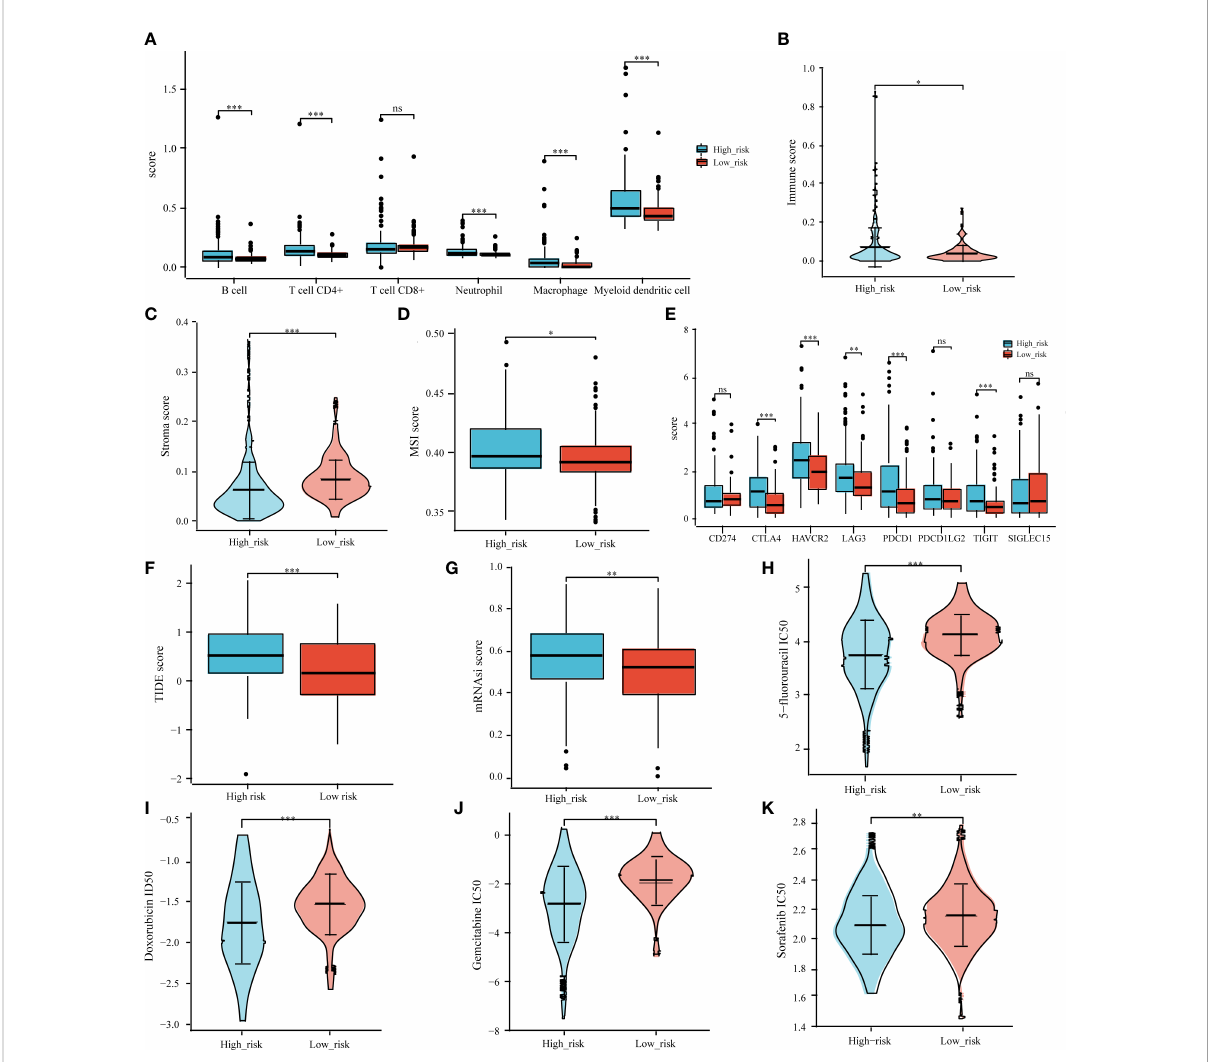
FIGURE 9 Correlation analysis of prognostic signature and tumor immune cell in fi ltration, immune checkpoint inhibitors, ICB response, MSI, tumor stemness, and common chemotherapeutic agents. Associations between the IICDL signature and tumor immune cell in fi ltration (A) , immune score (B) , stroma score (C) , MSI score (D) , immune checkpoint inhibitors (E) , TIDE score (F) , mRNAsi score (G) , and IC 50 of chemotherapeutic drugs (H – K) . (*P < 0.05; **P < 0.01; ***P < 0.001; ns, not signi fi